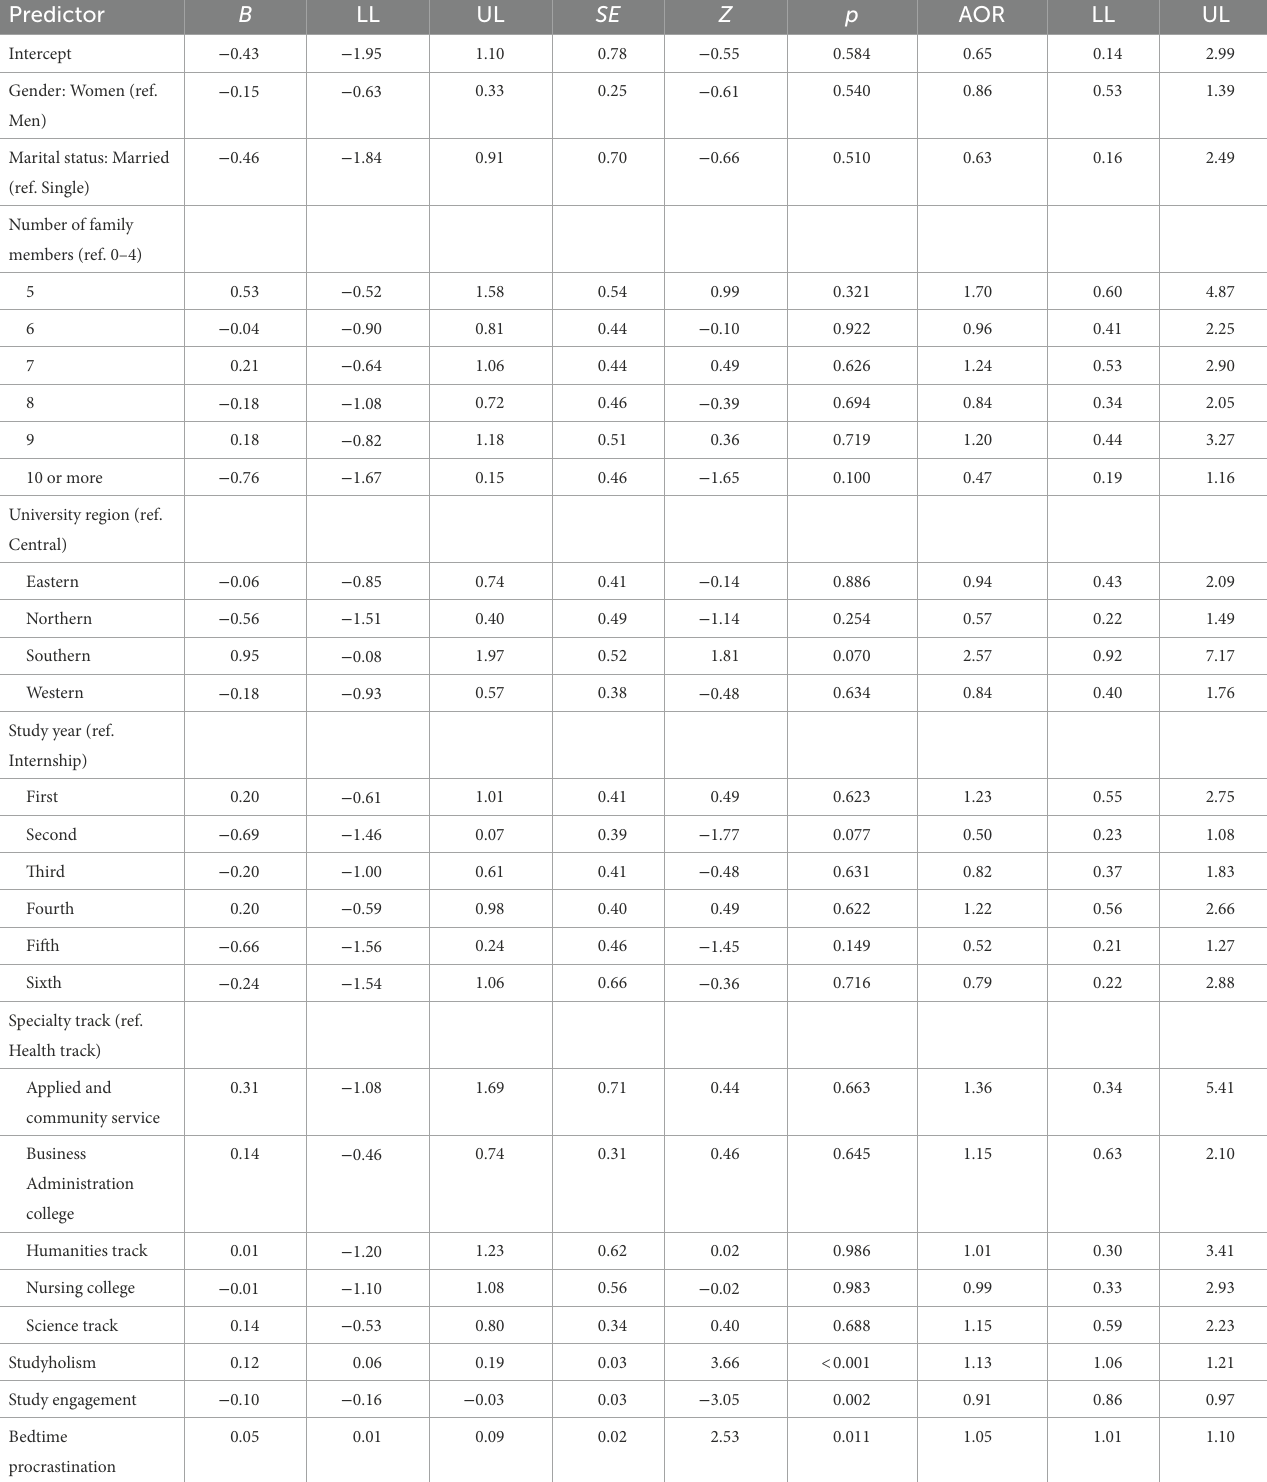
TABLE 7 Binomial logistic regression for insomnia (adjusted odds ratios).